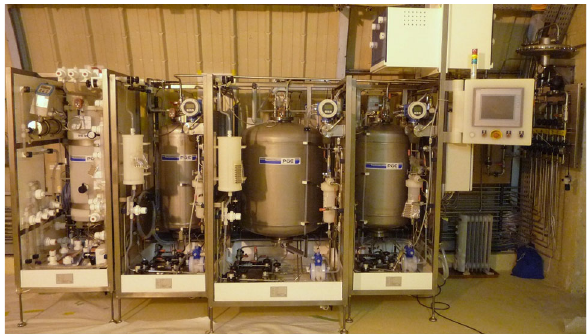
Fig. 9 Detector Fluid Operating System installed in the underground laboratory of the far detector. From left to right are shown: Target, GC, buffer and veto liquid systems; the control unit including touch screen; the over-, underpressure safety and low pressure nitrogen boxes, and one of the gas system manifolds